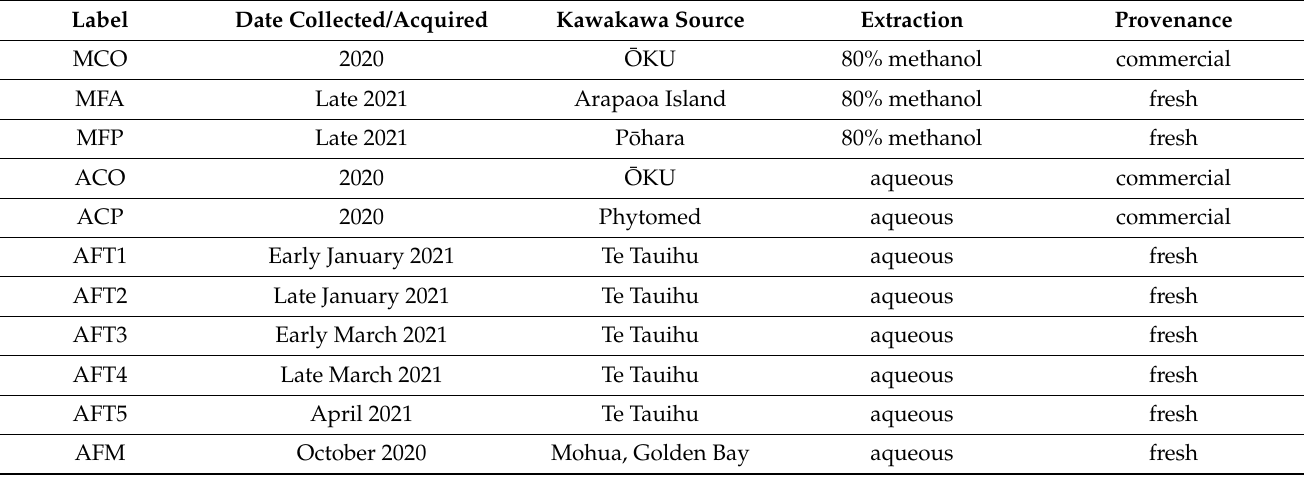
Table 1. Labels for the different kawakawa leaf powder samples extracted and analysed here and used in the rest of the manuscript. The first letter indicates methanolic or aqueous extraction, the second letter commercial dried leaves or fresh leaves and the third the source. Te Tauihu samples were collected on multiple occasions throughout 2021, so a number is added to the label to index